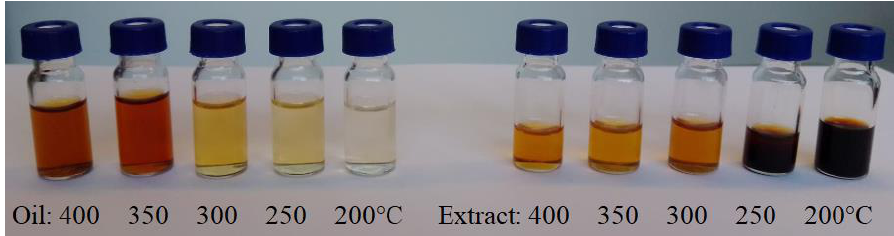
Figure 7. Extracts from the obtained chars ( left ) and pyrolytic oil ( right ).